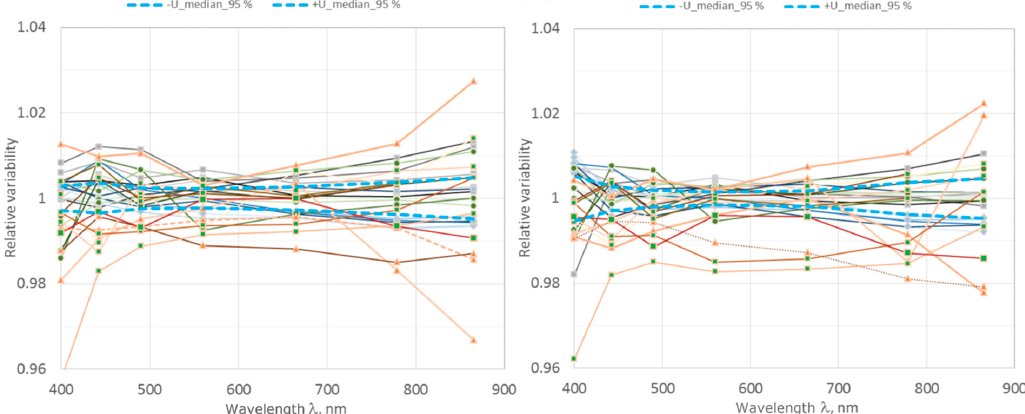
Figure 8. Comparison of low intensity ( left ) and high intensity radiance ( right ) sources as measured by each participating instrument compared to the median over all instruments; after reviewing data by pilot, corrections submitted by participants and/or unified data handling by pilot. Blue dotted lines—expanded uncertainty of the median consensus value. Reproduced with permission from [45].